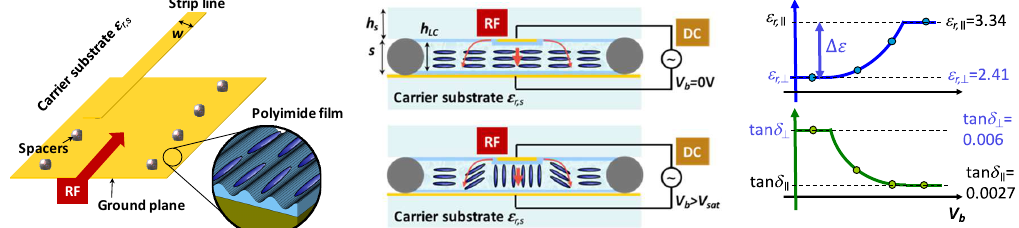
Figure 16. Schematic of a tunable LC-filled inverted microstrip line (IMSL), using the hybrid biasing concept with polyimide films on top of the ground plane and strip line, both processed on a carrier substrate with ε r,s ( left ). The cross-section illustrates its assembly: strip line ( top ) and ground plane ( bottom ) processed on glass carrier substrates with ε r , s , each covered by thin, rubbed polyimide films (thin blue lines) for the unbiased state V b = 0 V and a fully biased state V b > V sat ( center ). Permittivity and loss tangent versus bias voltage V b ( right ). The values are given for the LC TUD-566.